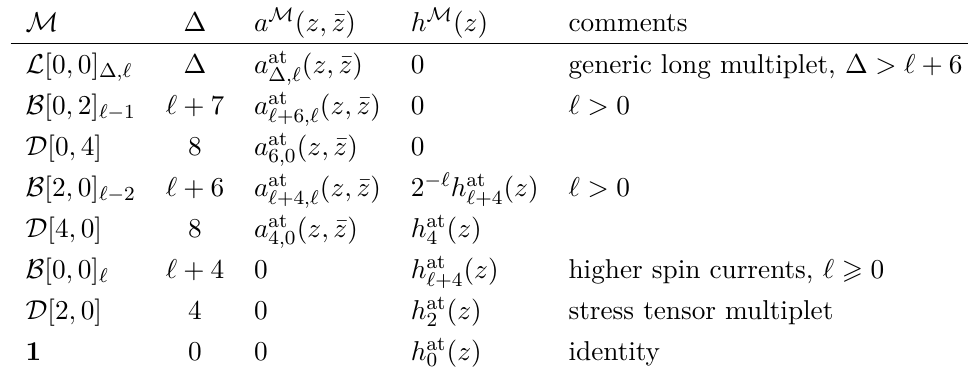
Table 1. Superconformal blocks contribution from all superconformal multiplets appearing in the OPE of two stress tensor multiplets. The contributions are determined from the atomic building blocks. Bose symmetry requires that ‘ is an even integer. Here ∆ is the dimension of the superconformal